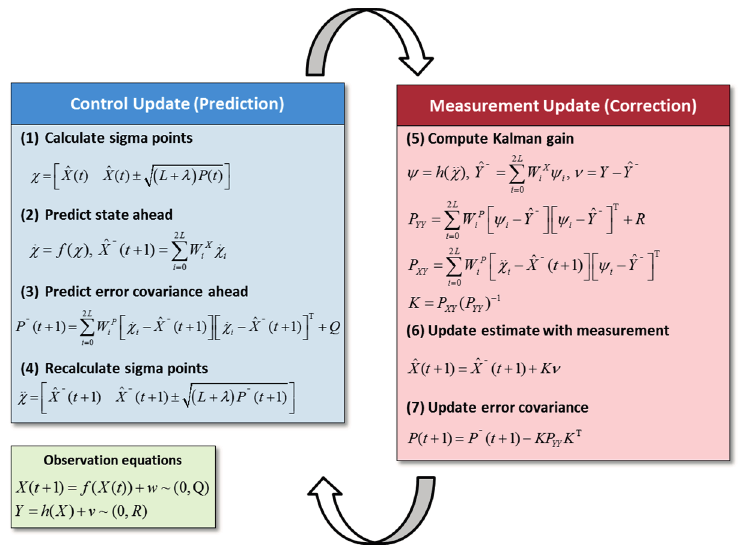
Figure 5. Process of Unscented Kalman filter.